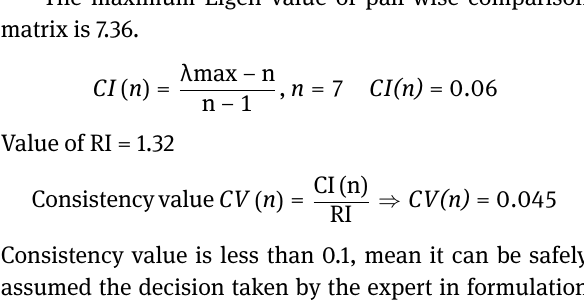
for all the sub factors defined as level 3 factors can be calculated in relation to their factor at level 1 using the methodology as described